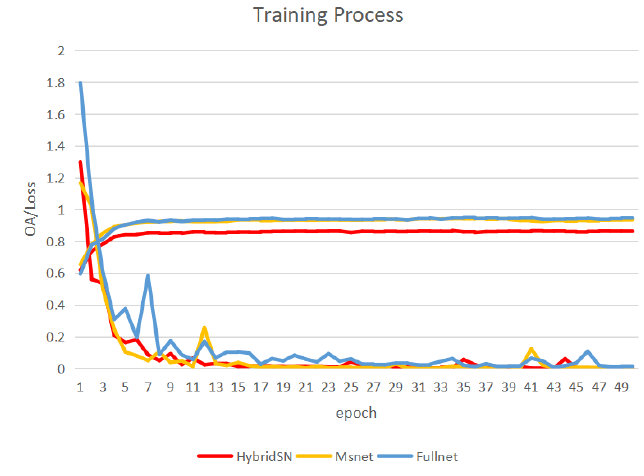
Figure 6. OA and loss in the training process. Table 5. Experiment on ratio